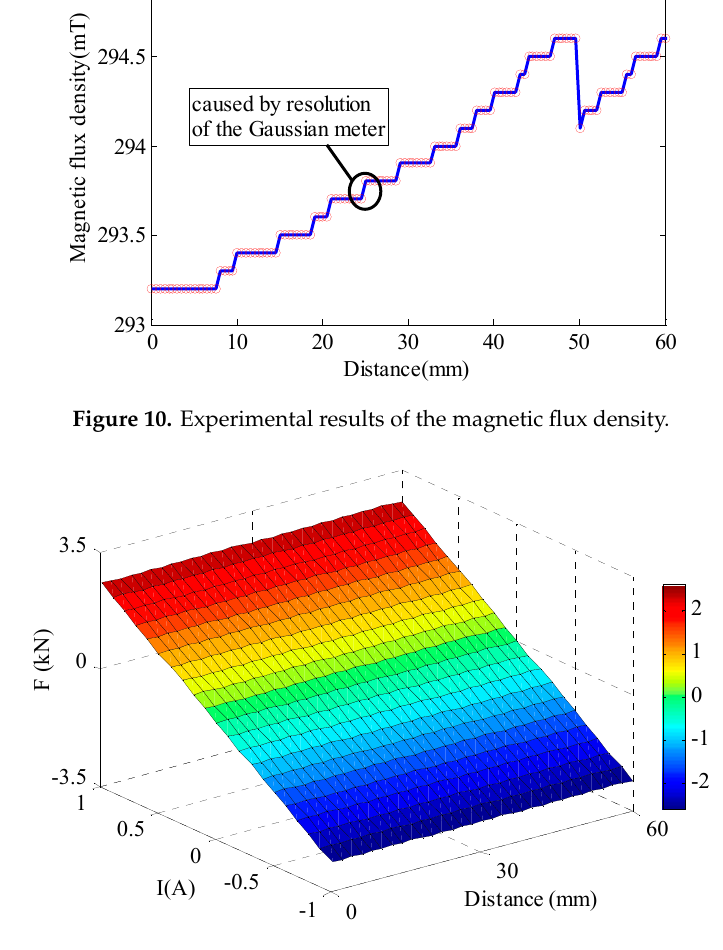
Figure 11. Magnetic force–drive current curved surface of the electromagnetic actuator.